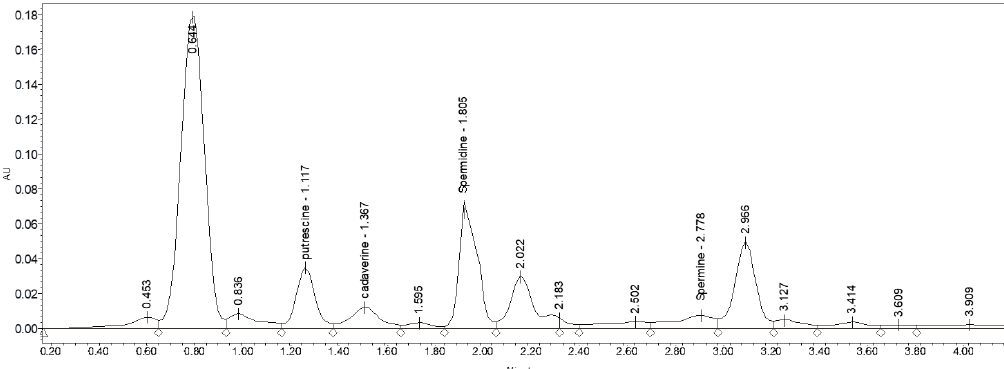
Figure 2. Chromatogram of polyamines found in cauliflower florets under short-term heat stress at extreme temperature and preharvest foliar 4 mM arginine treatment. Table 7. Polyamine content (nmoles g − 1 FW) of cauliflower florets affected by short-term heat stress and foliar arginine application.